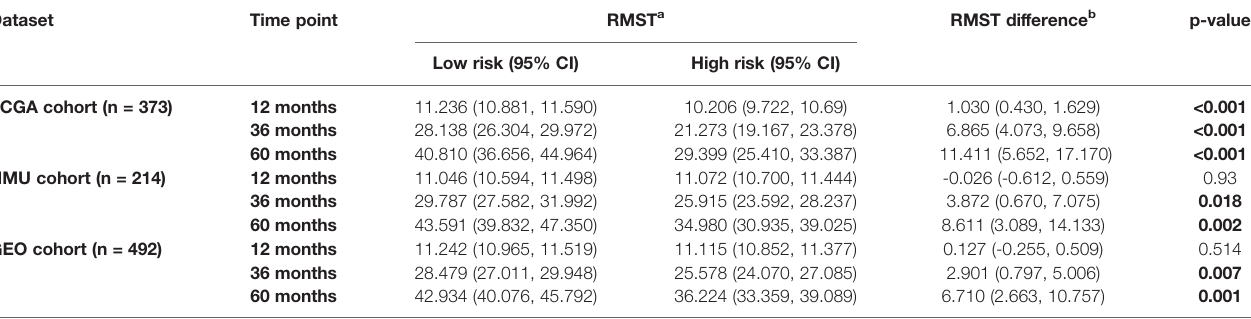
TABLE 1 | RMS time (RMST) between the two risk groups at different time points.